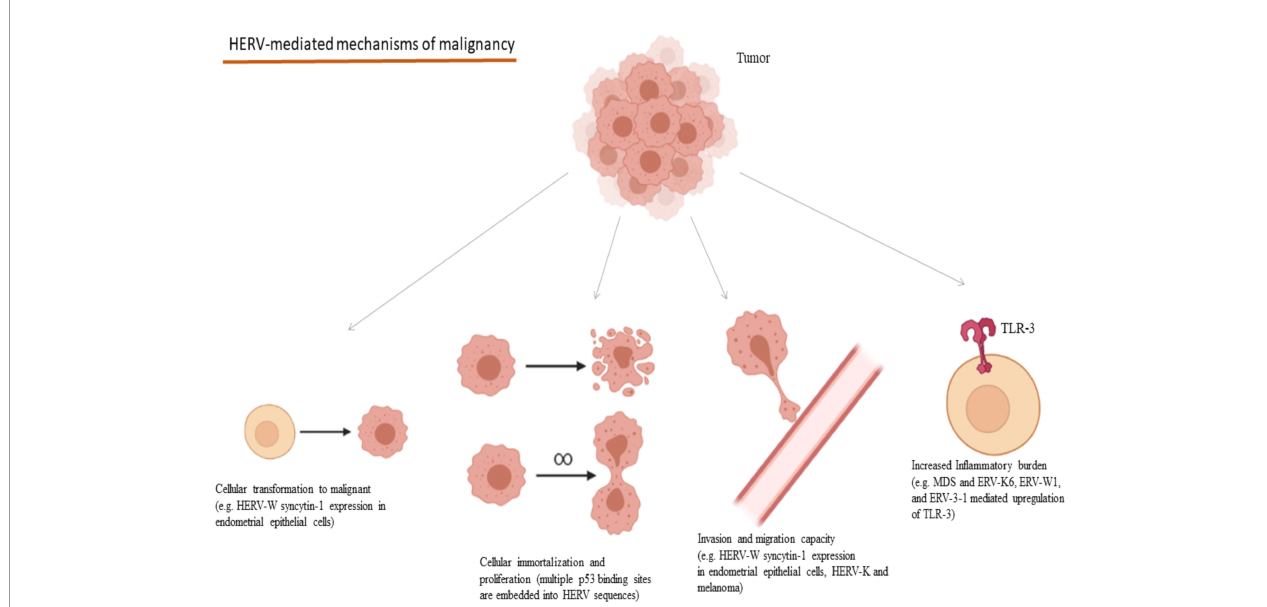
FIGURE 4 | Oncogenic mechanisms mediated through HERVs and selected examples of their implications in cancers. (HERV, Human Endogenous Retrovirus; MDS, Myelodysplastic Syndrome; TLR, Toll-like Receptor). Created in